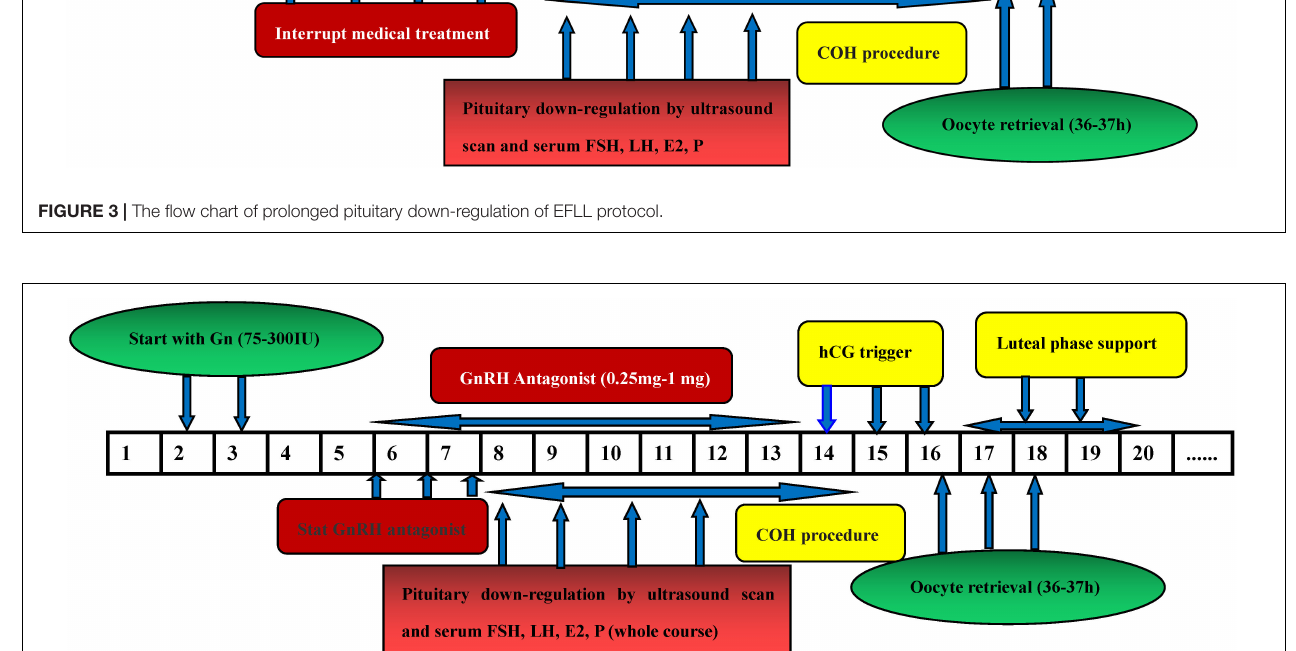
FIGURE 4 | The flow chart of GnRH antagonist protocol. Figures 5 , 6 comparison of treatment results among the three groups.